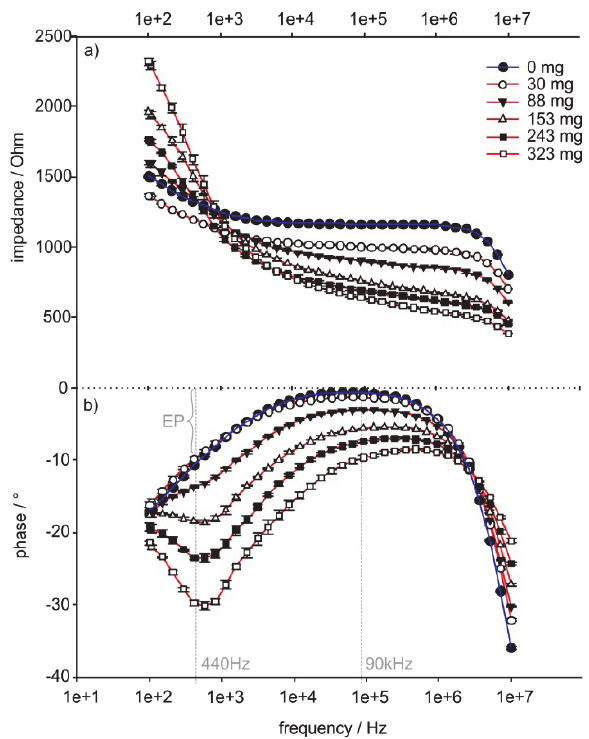
Fig. 3: Impedance (a) and phase (b) against frequency plotted for 6 different amounts of living Lumbriculus variegatus fed with TetraMin ® measured in buffered tap water. The two evaluation frequencies and the contribution of electrode polarization to the phase shift are marked grey.